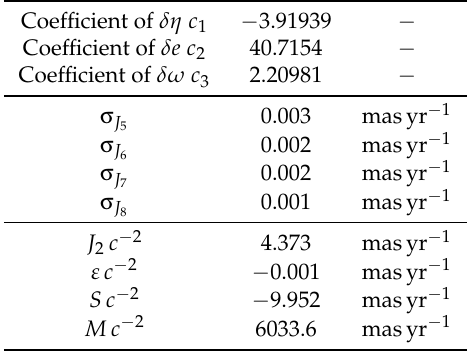
Table A9. Numerically integrated nominal rates of change, averaged over one orbital revolution, of the semimajor axis a , the eccentricity e , the inclination I , the longitude of the ascending node Ω , the argument of pericenter ω , and the mean anomaly at epoch η induced by the neutral atmospheric drag for the orbital configuration of Table A6. The units are m yr − 1 for (cid:104) ˙ a (cid:105) , and mas yr − 1 for (cid:104) ˙ e (cid:105) , (cid:10) ˙ I (cid:11) , (cid:10) ˙ Ω (cid:11) , (cid:104) ˙ ω (cid:105) , (cid:104) ˙ η (cid:105) . For the satellite, assumed spherical in shape and passive, we adopted C 3.5, Σ = 2.69 × 10 − 4 as for the existing LARES [53]. In regard to the Earth’s neutral atmospheric density, we adopted r 0 = r min = a ( 1 − e ) = 641.86km, ρ 0 = ρ max = ( 6.9 − 1.11 ) × 10 − 14 kgm − 3 , ρ min = 0.0001 ρ L , λ = 3463.23km − 3843.48km; the neutral atmospheric density at the height of